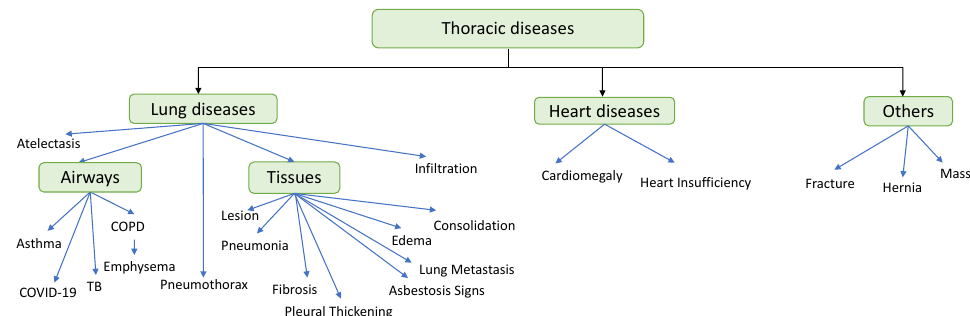
Figure 8. Thoracic diseases classification.